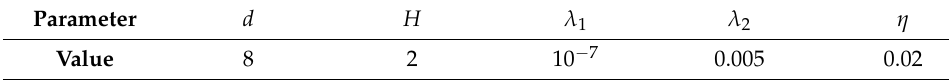
Table 10. Optimum performance parameters of RippleNet model.